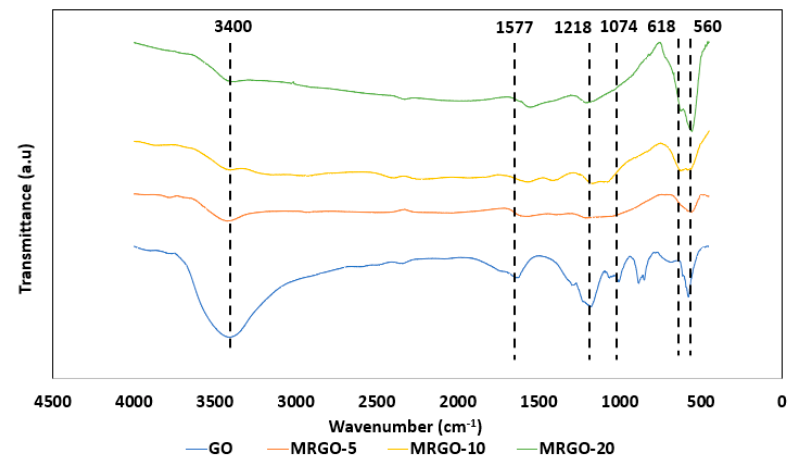
Figure 6. FTIR analysis of GO, MRGO-5, MRG-10 and MRGO-20.